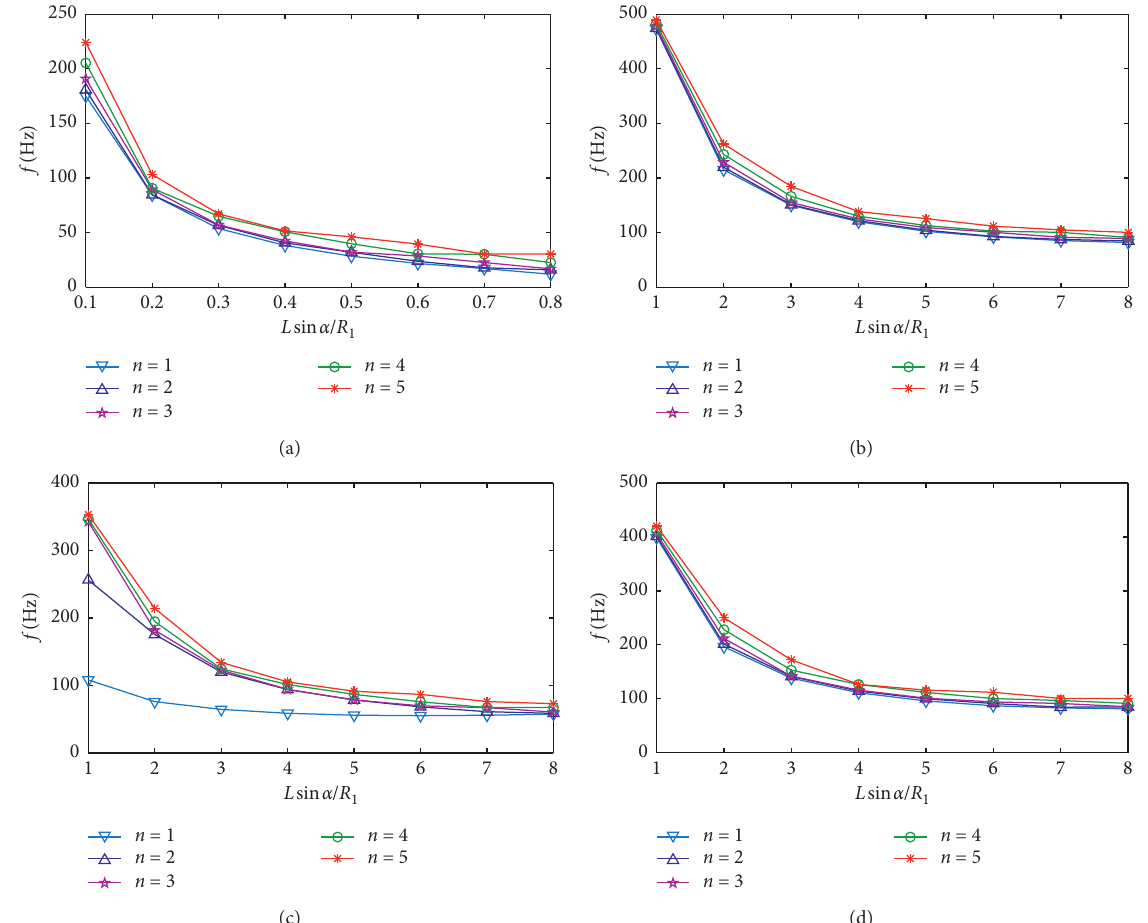
Figure 9: Frequency curves of the first 3 orders of the conical shell with different length-diameter ratios. (a) C–F. (b) C–C. (c) S–S. (d) S–C.